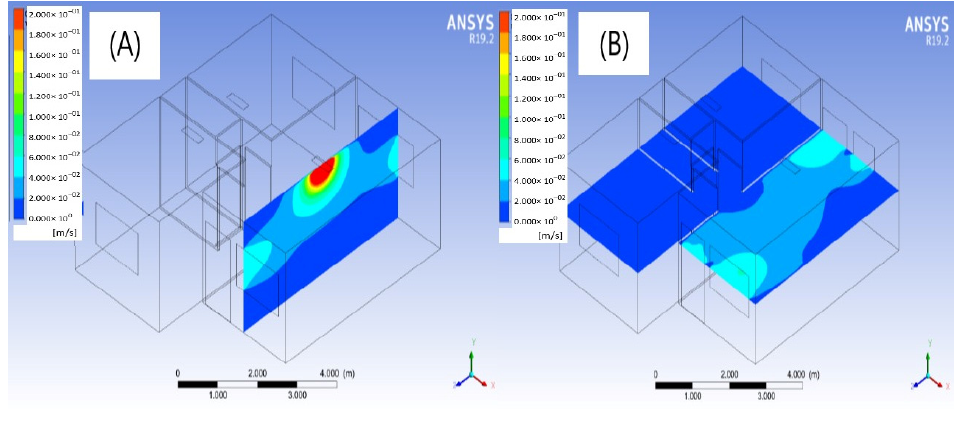
Figure 10. Velocity magnitude in the z–y plane ( A ) and in the z–x plane ( B ) for a rectangular channel, with the air outlet concentrated in the common area.